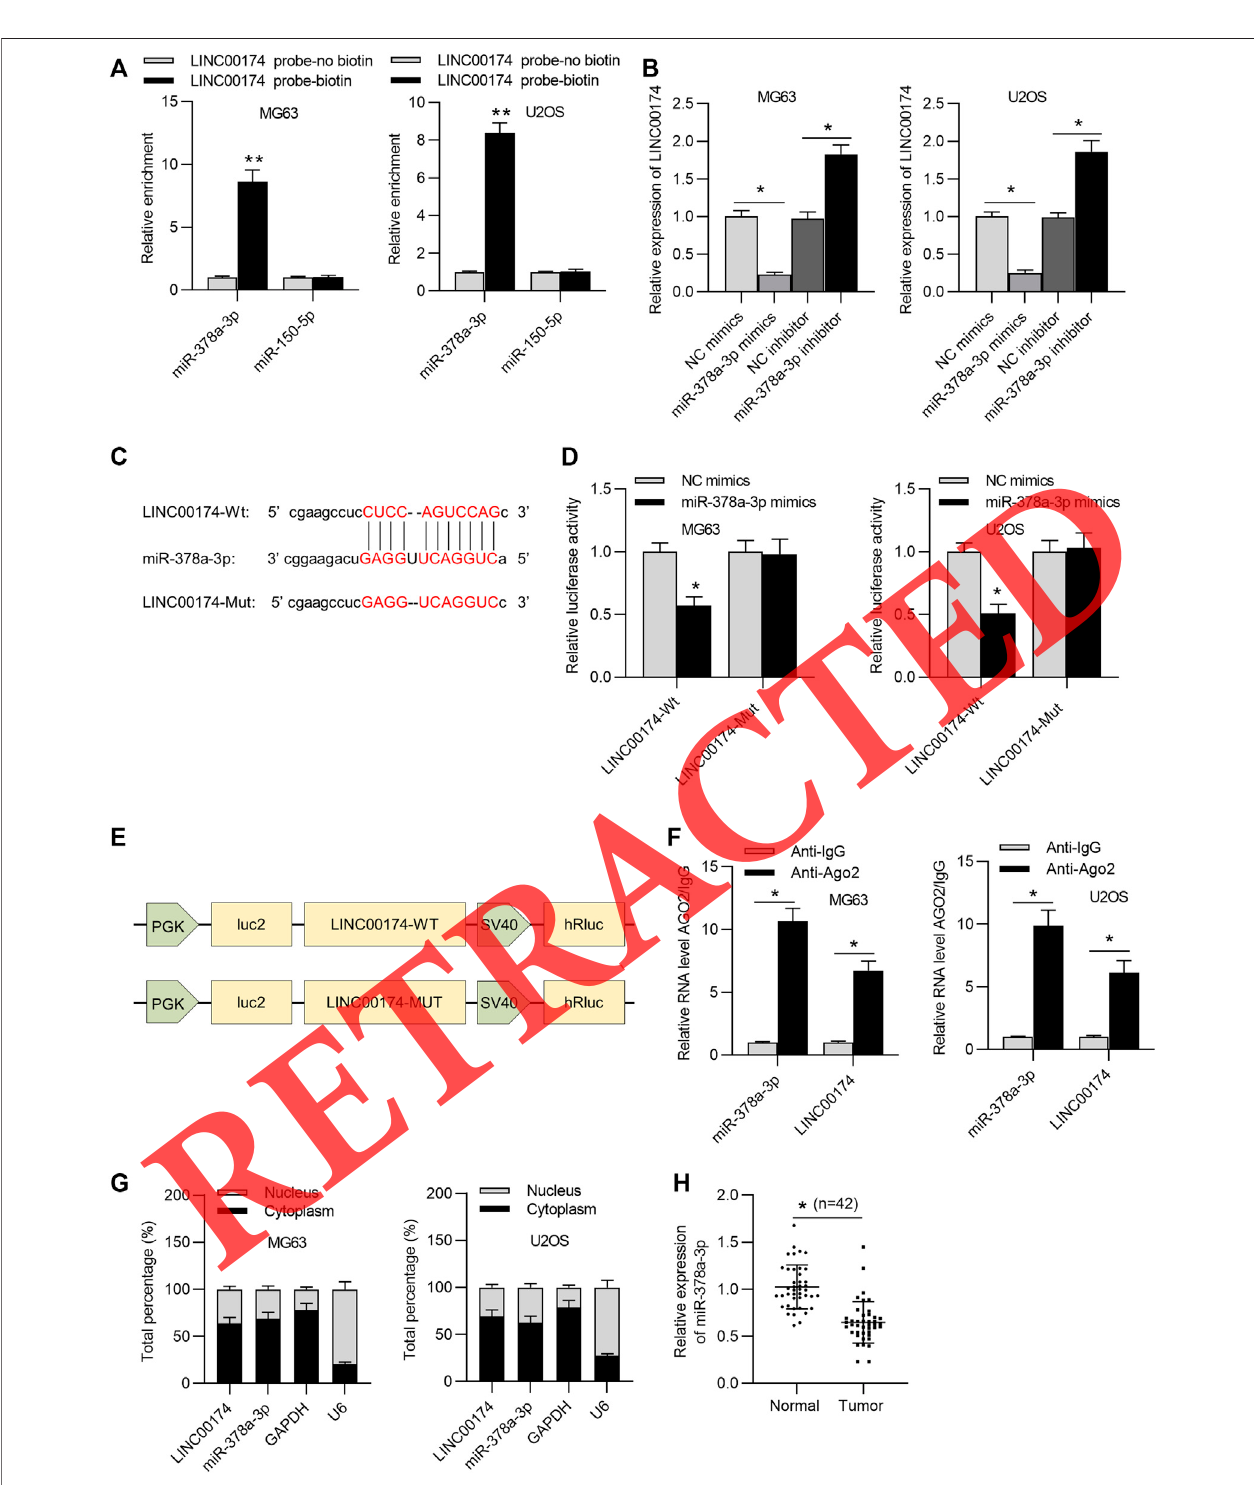
FIGURE 4 | LINC00174 is a molecular sponge for miR-378a-3p. (A) RNA pull-down assay was used to measure the enrichment of predicted miRNAs in pellets pulled down by biotinylated LINC00174 in OS cells. Signi fi cance was analyzed by Student ’ s t-test. (B) The expression of LINC00174 in OS cells in NC mimics, miR- 378a-3p mimics, NC inhibitor or miR-378a-3p inhibitor group was detected by RT-qPCR. Signi fi cance was analyzed by Student ’ s t-test. (C) The predicted binding site between LINC00174 and miR-378a-3p was obtained from starBase. (D) Luciferase reporter assay assessed the binding ability between LINC00174 and miR- 378a-3p in OS cells. Signi fi cance was analyzed by Student ’ s t-test. (E) Corresponding schematic diagram of luciferase reporter plasmid. (F) RIP assay was used to evaluate the binding ability between LINC00174 and miR-378a-3p in OS cells. Signi fi cance was analyzed by Student ’ s t-test. (G) Subcellular fractionation assay detectedthecolocalizationofLINC00174andmiR-378a-3pinOScells. (H) MiR-378a-3pexpressioninOStissuesandadjacentnontumortissueswasdetectedbyRT- qPCR. Signi fi cance was analyzed by Student ’ s t-test. * p < 0.05, ** p < 0.01.